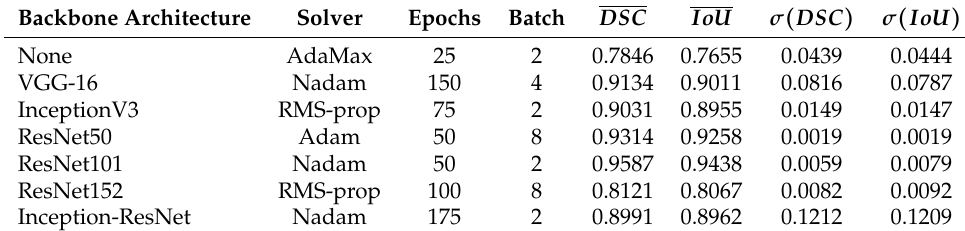
Table 7. Results achieved with images in the frontal